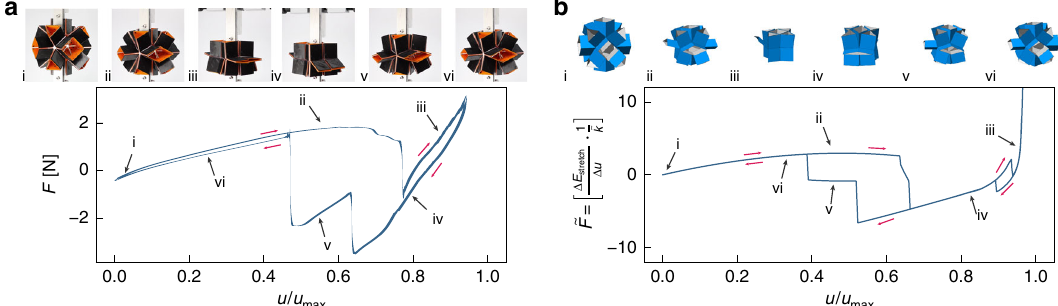
Fig. 2 Comparison of multistable behavior between experimental and numerical compression tests. a Average force – displacement response obtained by cyclic loading ( fi ve times) of an experimental prototype of a prismatic structure based on a cuboctahedron made from 3D printed faces (2 × 0.5 mm thick PLA) connected by fl exible Mylar hinges (50 µ m thick). The standard deviation is indicated by the thickness of the line. The force changes sign when an energy barrier is crossed, indicating that the structure deforms from one stable state to another. b Normalized force – displacement response obtained with our numerical method for the same structure. The behavior of both the experiments and the simulations are strikingly similar, both showing one instability when compressing the structure and two when returning to the initial con fi guration. Note that a small hysteresis loop observed in simulations at the end of the compression is not captured in experiments possibly due to a small misalignment when clamping the structure or small fabrication errors of